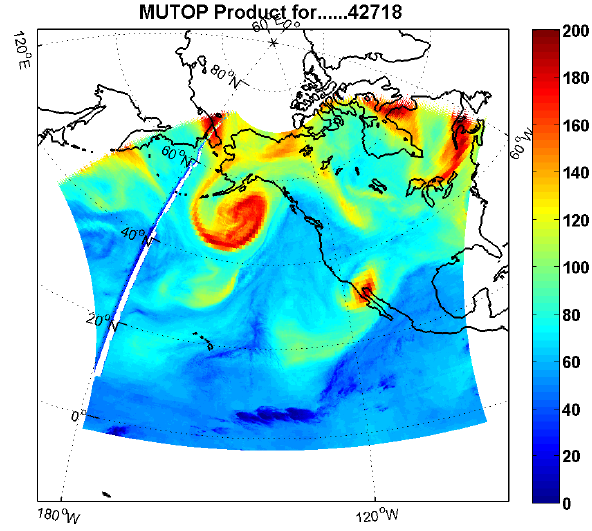
Fig. 6. Example MUTOP retrieval from 27 April 2006 at 18:00UTC depicting ozone across the GOES-West domain. Up- per tropospheric layer-average ozone mixing ratio is shaded in color in